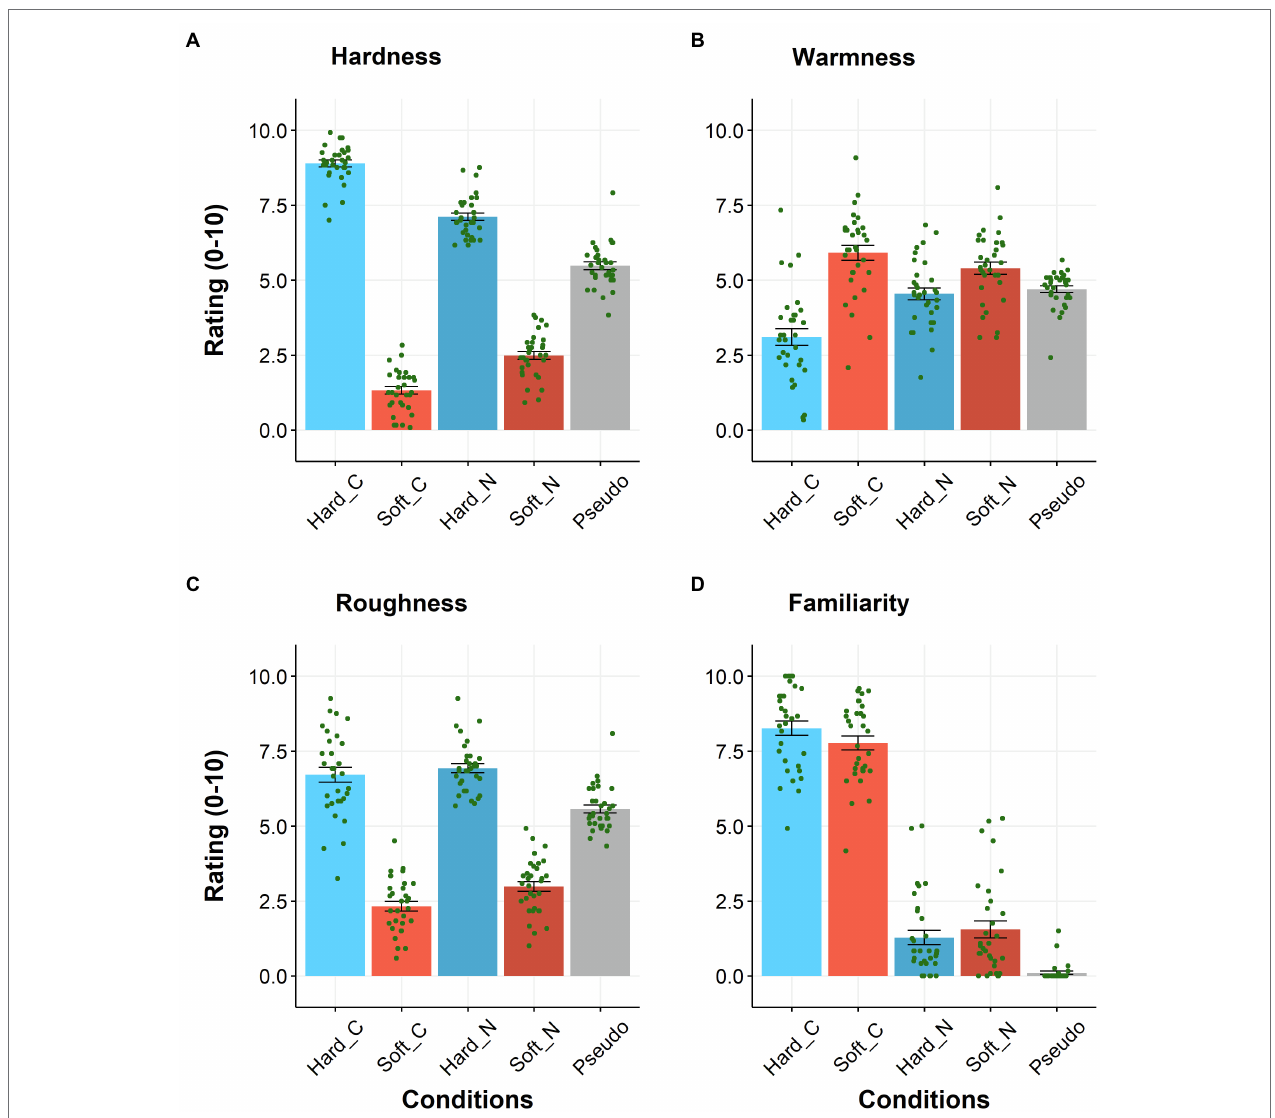
FIGURE 1 | Japanese subjects’ ratings for hardness (A) , warmness (B) , roughness (C) , and familiarity (D) . Hard_C, Soft_C, Hard_N, Soft_N, and Pseudo indicate conventional “hard,” conventional “soft,” novel “hard,” and novel “soft” words, as well as non-sound-symbolic pseudowords, respectively. N = 32. Error bars indicate the standard errors of the mean (SEM), and each dot indicates each subject’s